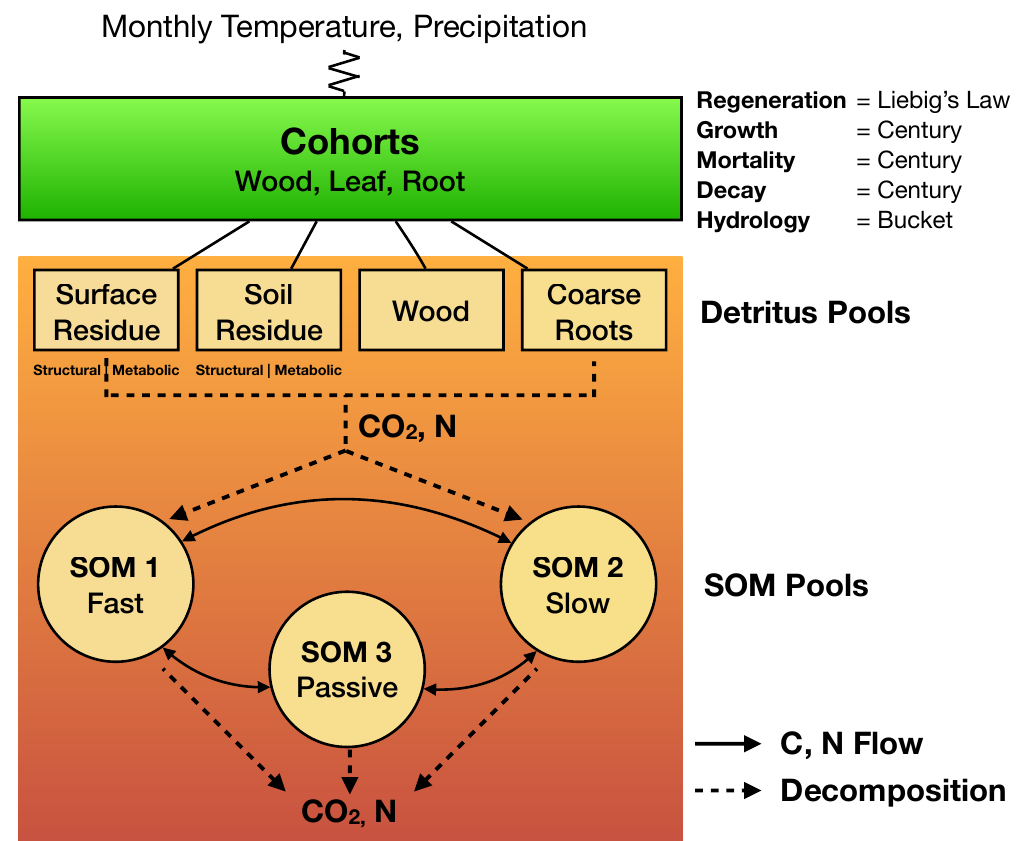
Figure 1. LANdscape DIsturbance and Succession II Net Ecosystem Carbon and Nitrogen (LANDIS-II NECN) model